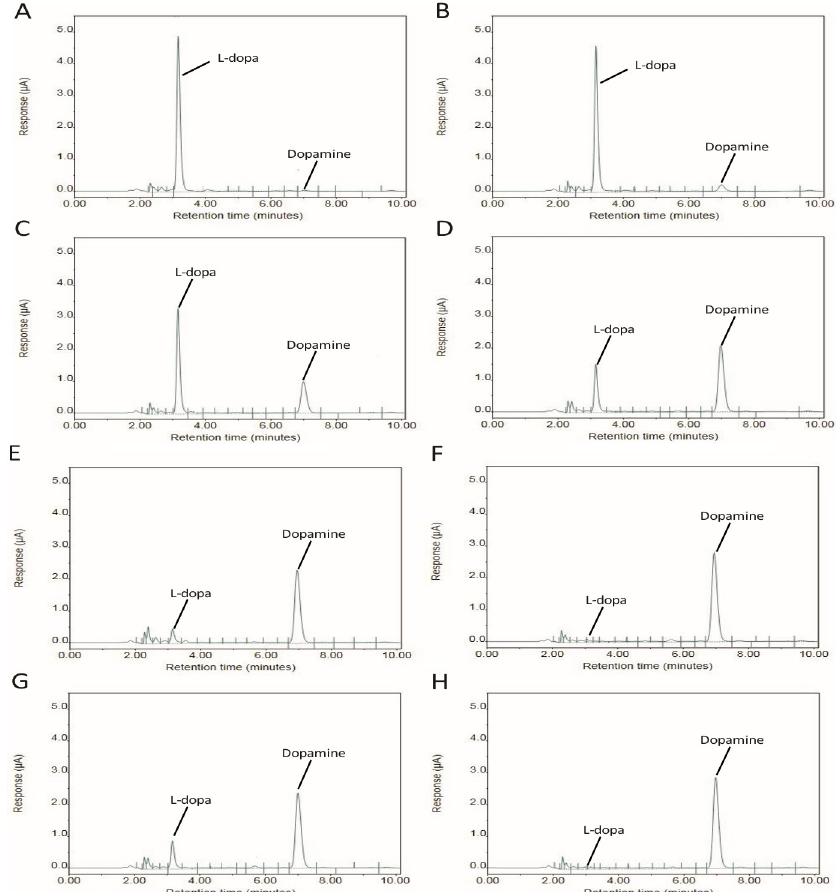
Fig 2. Chromatographic comparison of E . faecium strains. A) Control—No conversion. B,C) ML1087, ML1088 – Slight conversion ( < 30%). D) ML1085 –Moderate conversion (30%-74%). E,F) ML1089, ML1086 respectively–High level conversion ( > 75%). G,H) ML1081, ML1082—Two differing probiotic strains both demonstrating high levels of